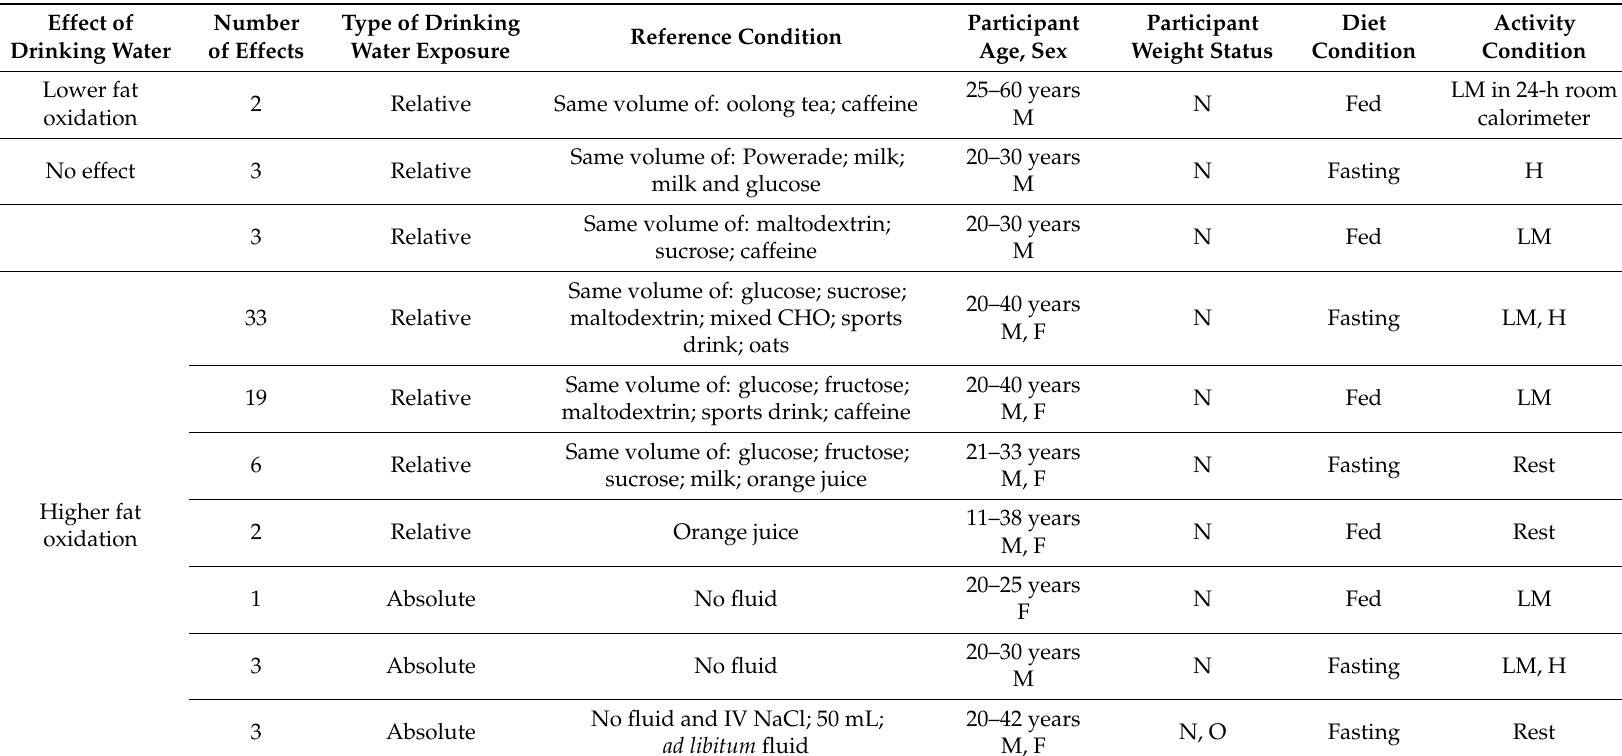
Table 4. RCT conditions associated with negative, null and positive effects of plain drinking water on fat